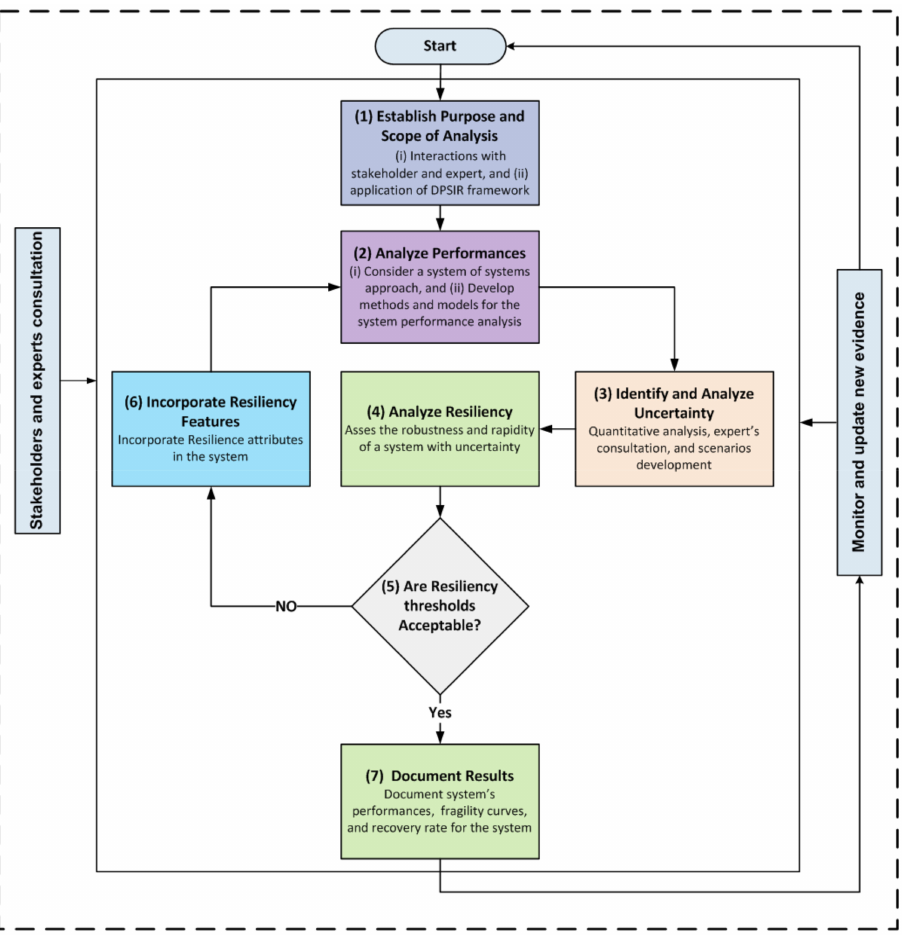
Figure 2. Proposed framework to assess and incorporate resilience in water